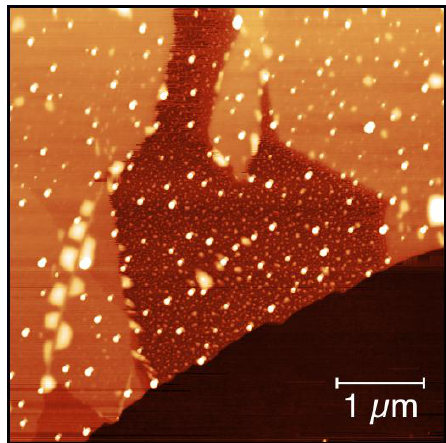
Figure E3. AFM tapping image of a ZrSe 2 flake after one day of sample exposure to the air.